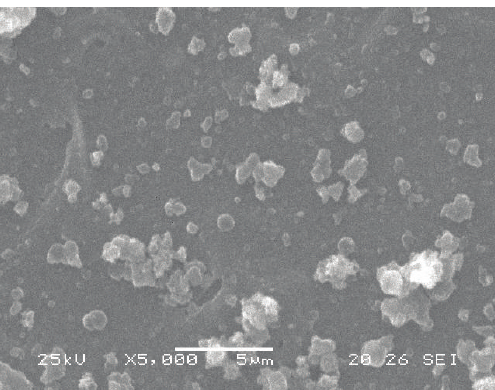
Figure 1: SEM micrograph of an electrodeposited POT thin film on ITO-coated